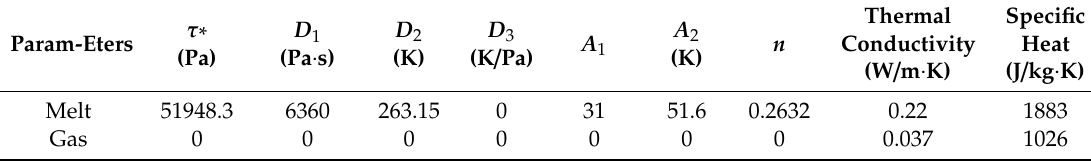
Table 3. Numerical simulation parameters of the melt and air.